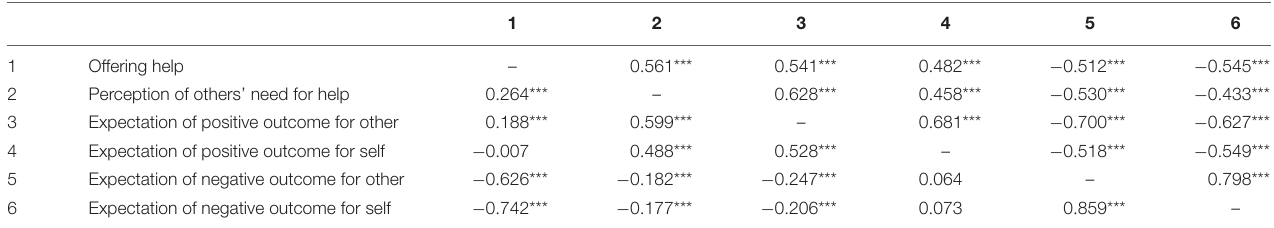
TABLE 3 | Correlations of main variables among American ( n = 397) and Japanese participants ( n = 399) in Study